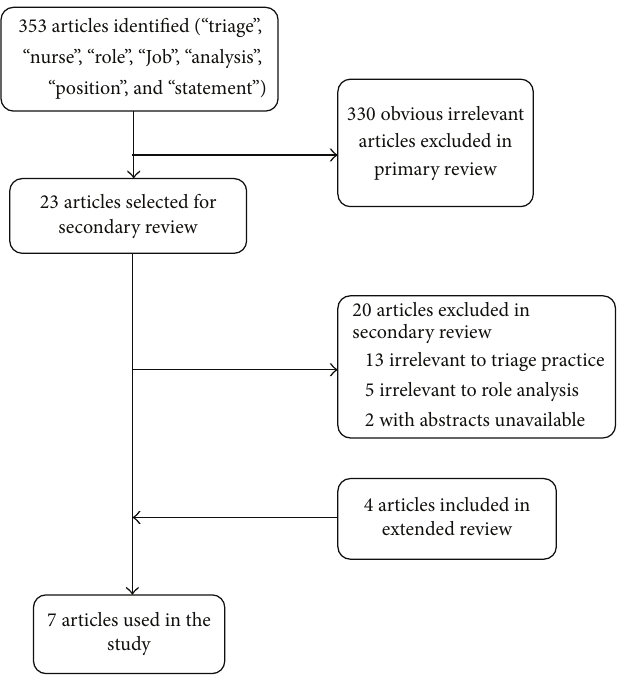
Figure 1: Study selection